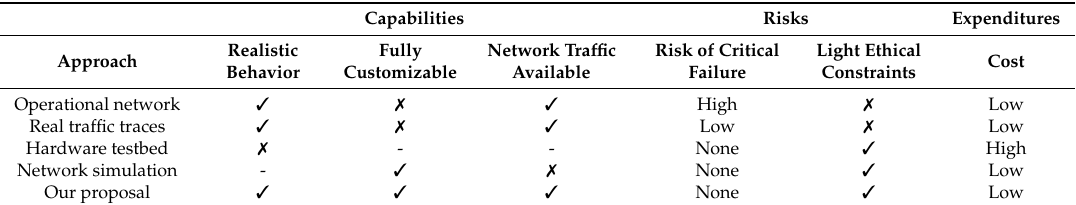
Table 3. Qualitative comparison of testing